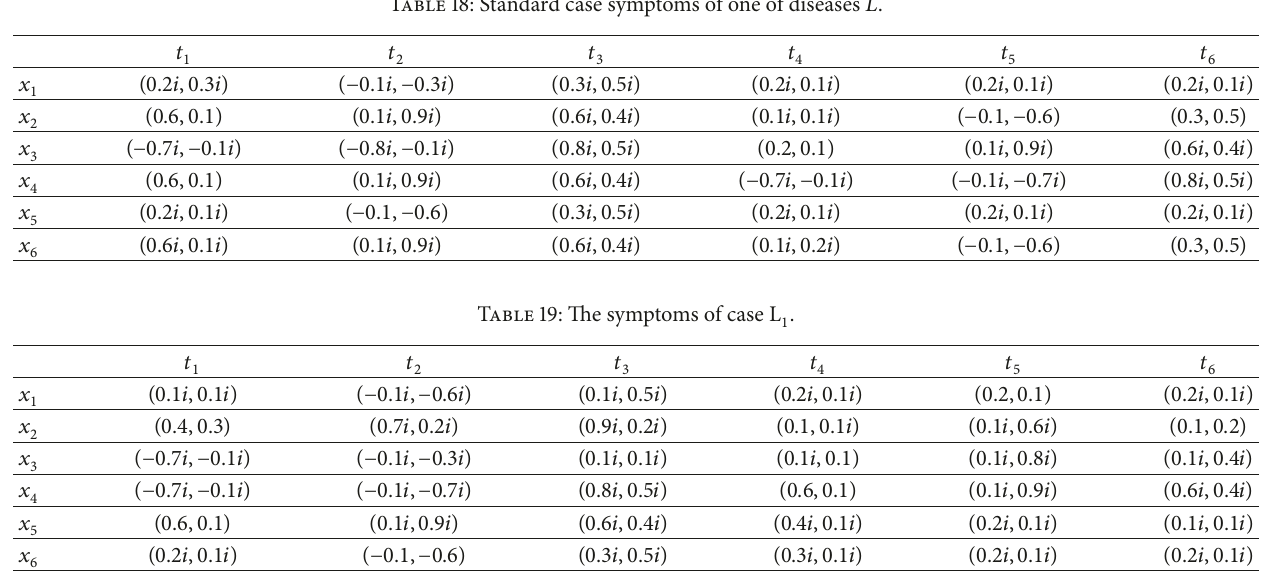
Table 18: Standard case symptoms of one of diseases 𝐿 .